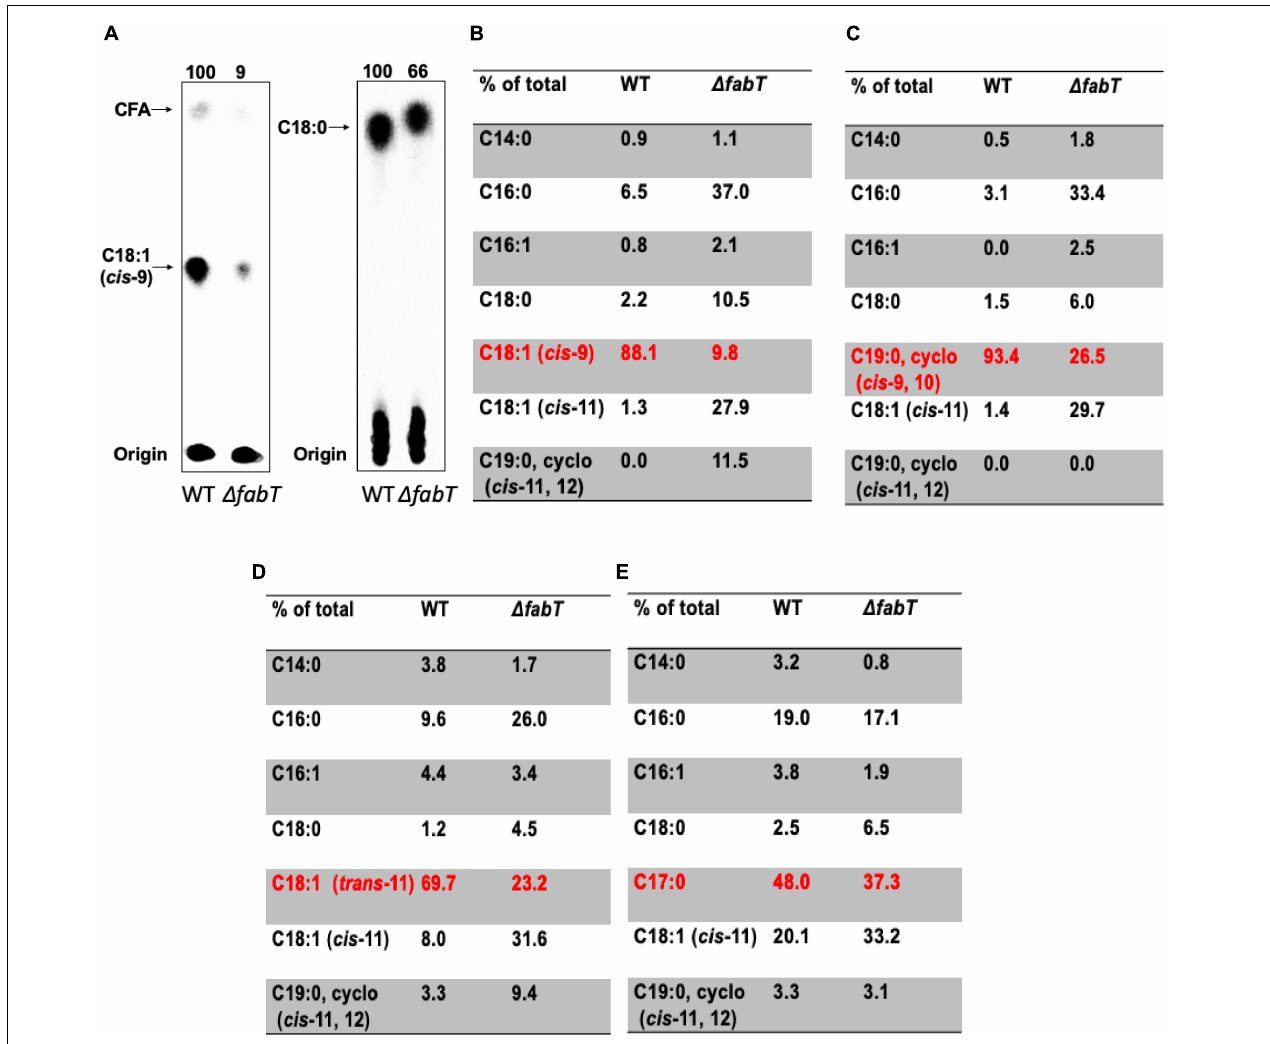
FIGURE 2 | The E. faecalis (cid:49) fabT strain is deficient in incorporation of exogenous fatty acids. (A) Incorporation of [ 14 C]oleic acid (at left) or [ 14 C]stearic acid (at right) into the cell membrane phospholipids of E. faecalis wild-type and (cid:49) fabT strains. (B) The acyl chain composition of cell membrane phospholipids of E. faecalis wild-type and (cid:49) fabT strains grown with oleic acid. (C) The acyl chain composition of cell membrane phospholipids of E. faecalis wild-type and (cid:49) fabT strains grown with the cyclopropane fatty acid, methyleneoctadecanoic acid. (D) The acyl chain composition of cell membrane phospholipids of E. faecalis wild-type and (cid:49) fabT strains grown with trans -vaccenic acid. (E) The acyl chain composition of cell membrane phospholipids of E. faecalis wild-type and (cid:49) fabT strains grown with the C17 saturated acid, margaric acid. In panel (A) , the lane of (cid:49) acpB (ZL318) cells at the right of the (cid:49) fabT lane was deleted because of the missense mutation detected in its fabT gene (see